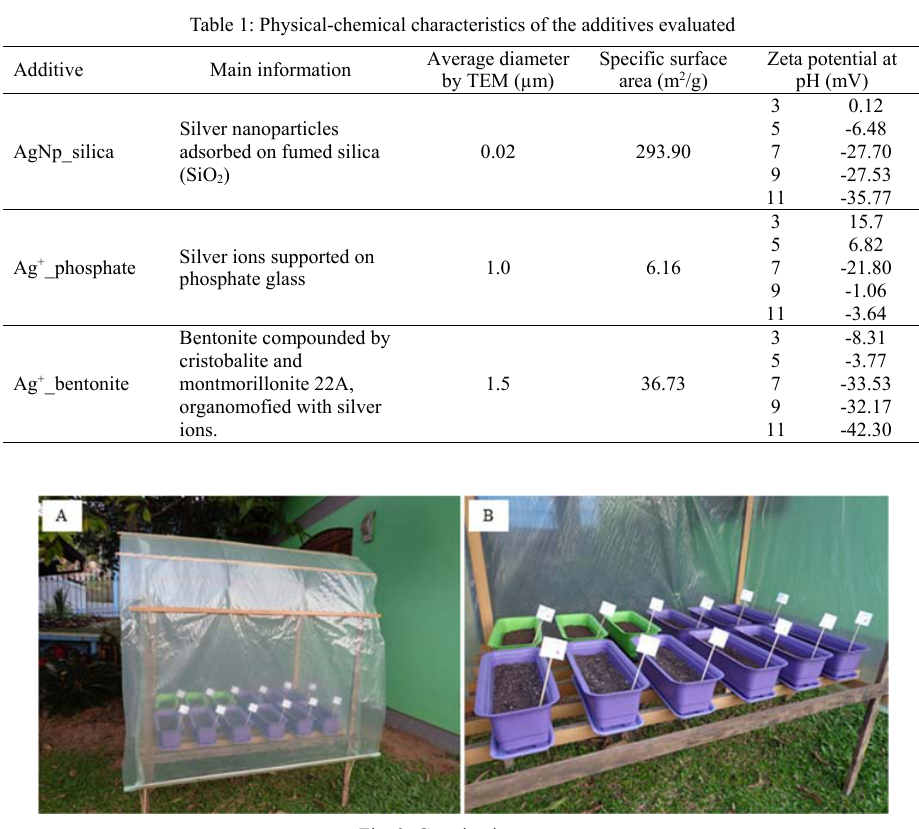
Fig. 2: Germination assay A) greenhouse used in the test and B) vessels arrangement within the